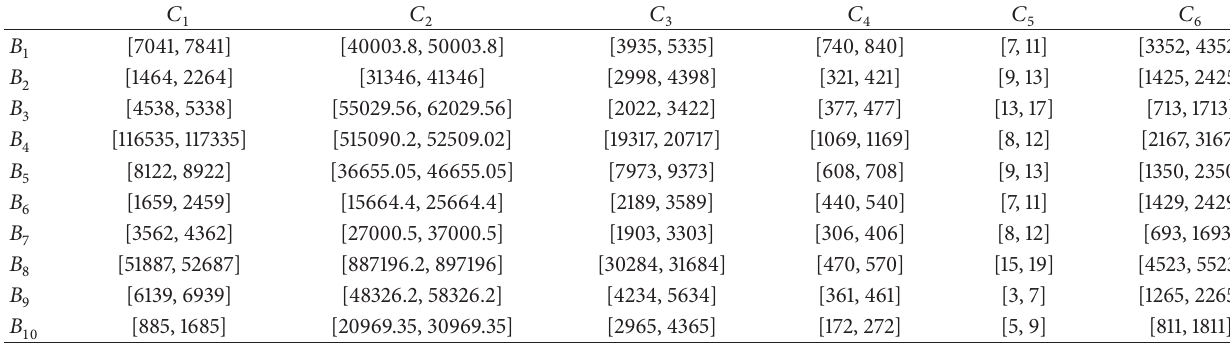
Table 8: Interval decision matrix in the first-time period (year of 2004).